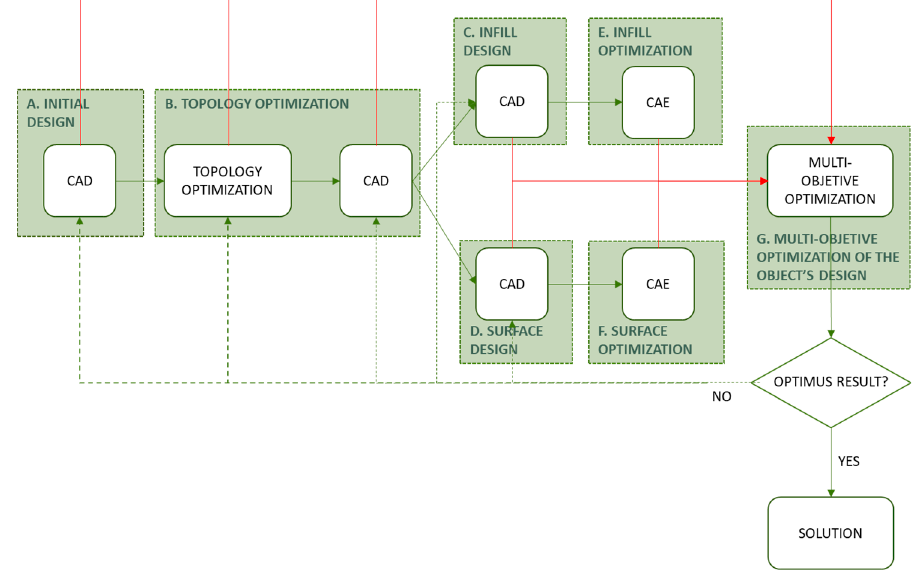
Figure 5. Diagram of the proposed methodology.